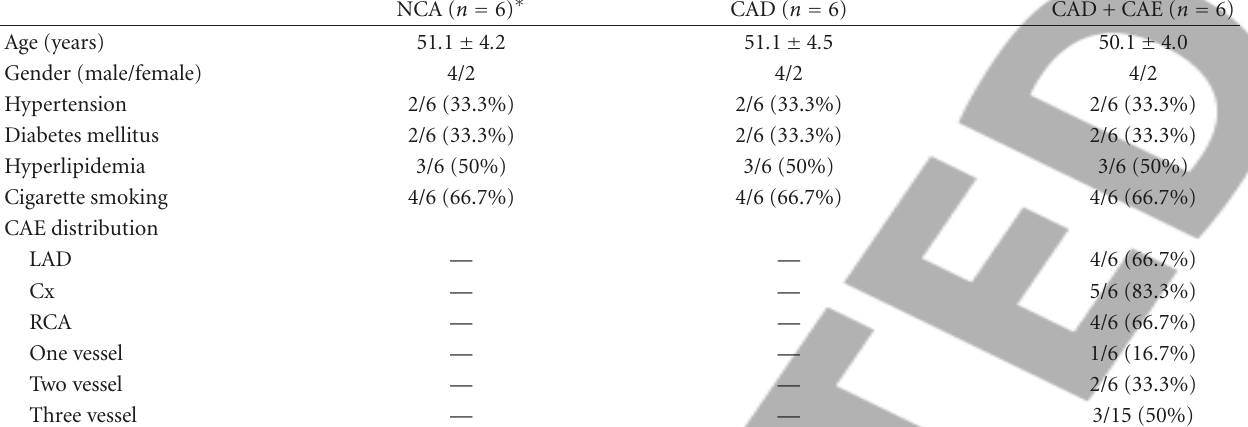
Table 1: Clinical and coronary angiographic findings of the study population.